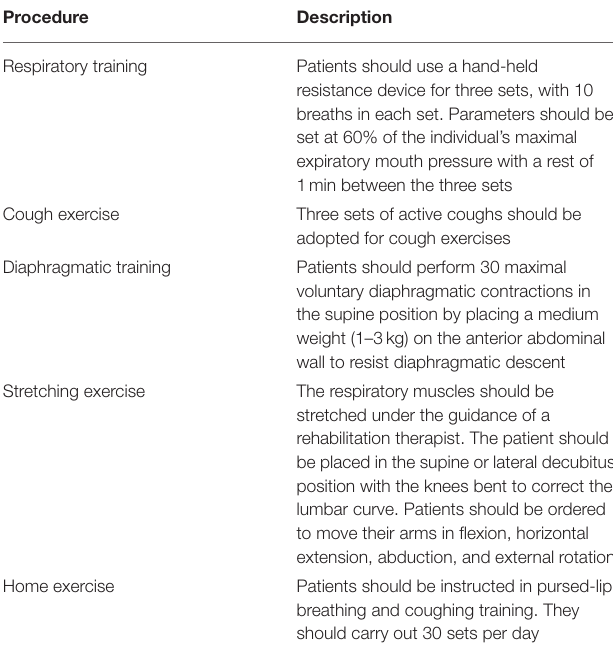
TABLE 4 | Description of the chest physiotherapy used in patients with COVID-19 after discharge [adopted from